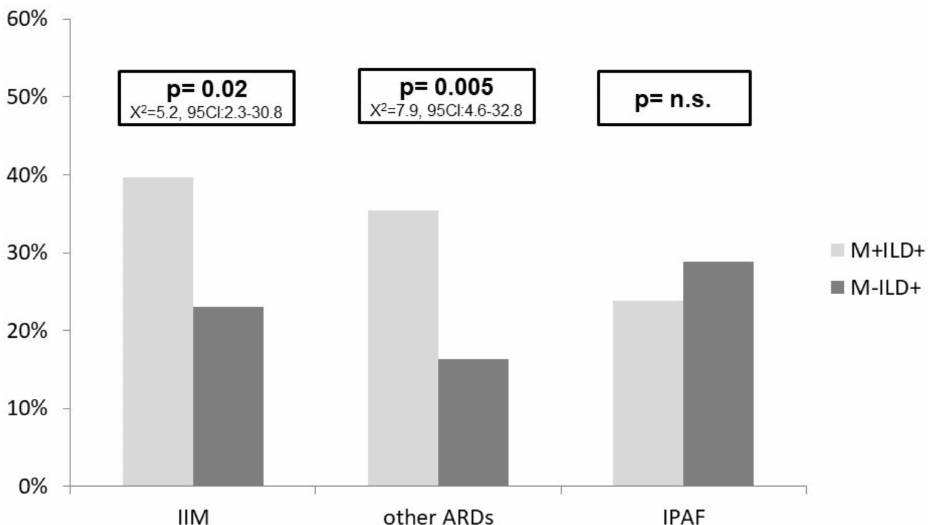
Figure 3. Diagnosis in ILD patients. Figure 3 Legend: ARD: autoimmune rheumatic disease; IIM: idiopathic inflammatory myopathies; ILD: interstitial lung disease; IPAF: interstitial pneu- monia with autoimmune features; M: myalgia. IIM: in this group we included dermatomyositis (DM), polymyositis (PM), antisynthetase syndrome (AS), overlap syndrome (OS) including myosi- tis. ARD: in this group we included patients with specific diagnosis of rheumatoid arthritis (RA), systemic lupus erythematosus (SLE), mixed connective tissue disease (MCTD), primary Sjögren’s syndrome (pSS), systemic sclerosis (SSc), OL condition not including myositis,